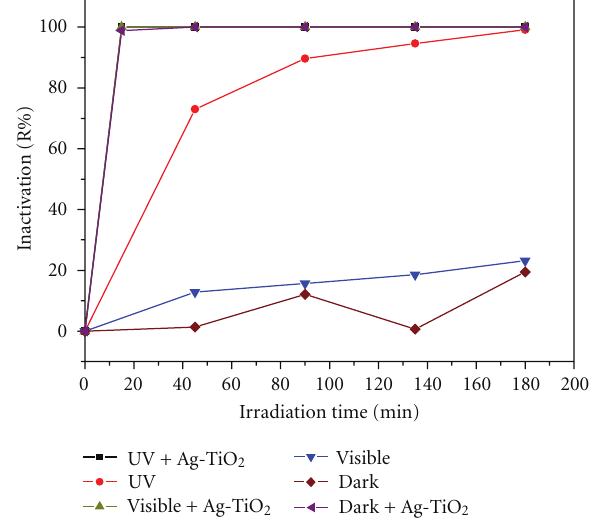
Figure 6: R percentage versus irradiation time of di ff erent light sources using TiO 2 as photocatalysts.